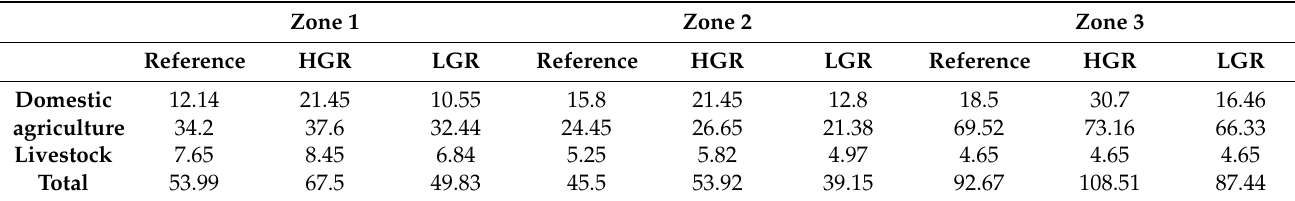
Table 4. Table of sector-wise groundwater unmet demand (in mcm) in 2050.